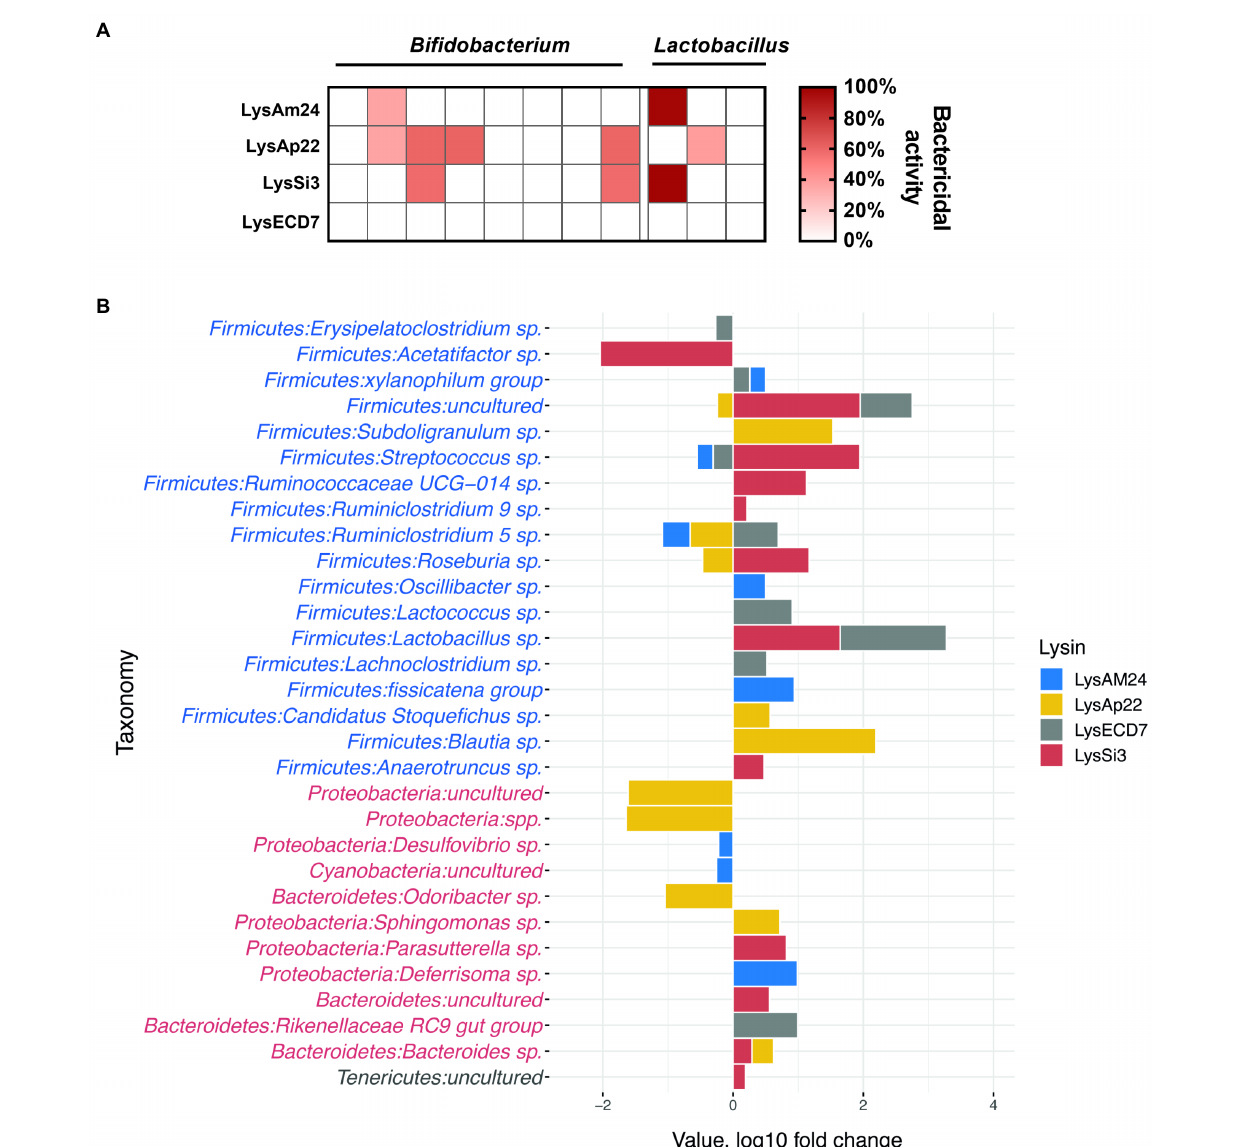
FIGURE 4 | Impact of endolysins on the normal bacterial flora. (A) In vitro activity of LysAm24, LysECD7, LysAp22, and LysSi3 against Bifidobacterium spp. and Lactobacillus spp. strains. Activity spectra were assessed at 100- μ g/ml endolysin concentration after 30-min incubation with bacterial suspension in a liquid medium. (B) Intestine microflora changes in mice under endolysin administration compared to control buffer (Tris–HCl) injections on the seventh day of experiment. Blue and red taxa indicate Gram-positive and Gram-negative bacteria